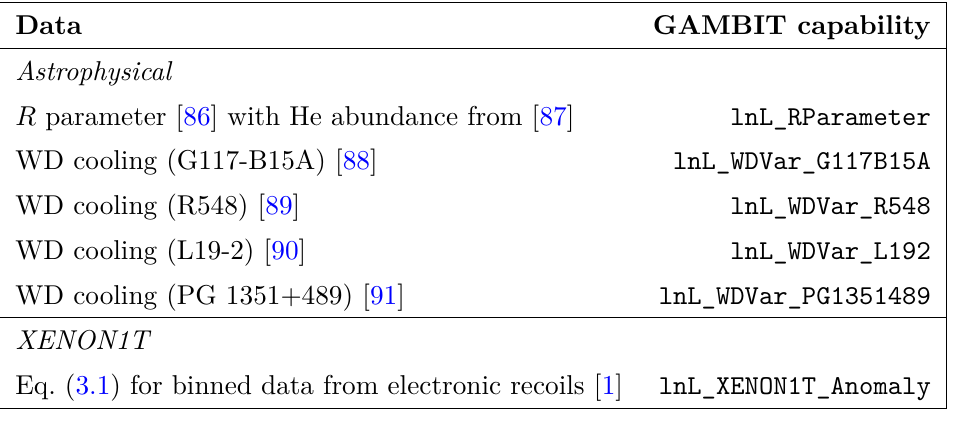
Table 1. Likelihoods included in the analysis. Note that the Xe likelihood and the high-mass corrections for the astrophysical likelihoods will be made available in a future release of the GAMBIT